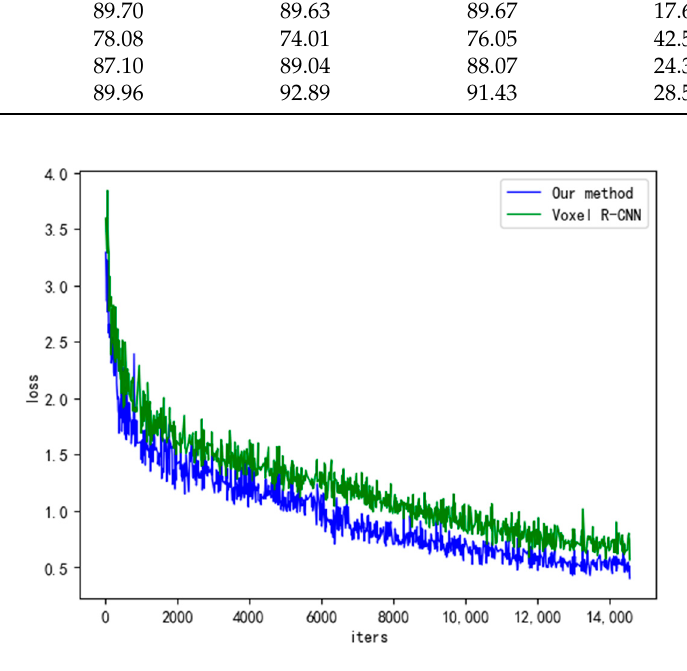
Figure 9. Loss curve of Voxel R-CNN and our method.